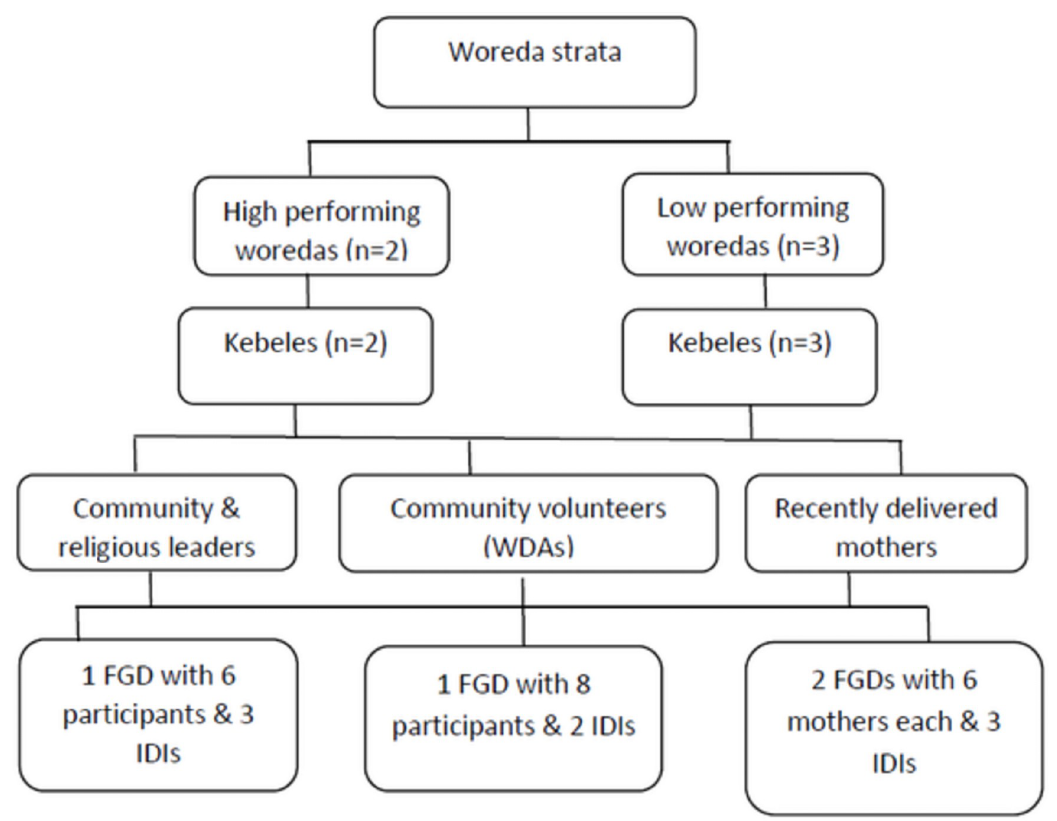
Fig 1. Sampling frame for the qualitative study. The principal investigator and research assistants collected and analyzed informational redundancy, data saturation, after conducting three FGDs and six IDIs [39].